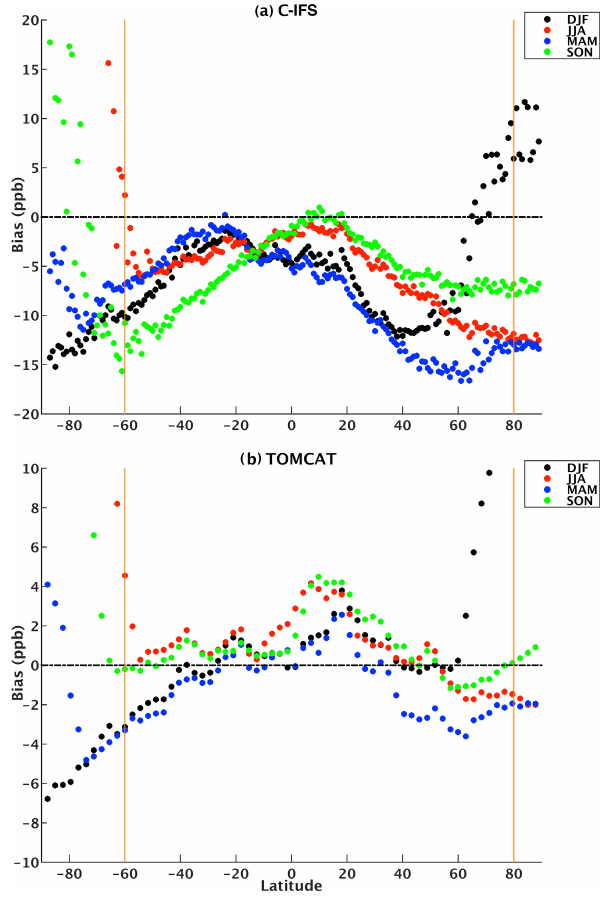
Figure 9. Zonal mean CH 4 stratospheric column bias for differ- ent seasons of the year 2010 plotted against latitude for the mod- els (a) C-IFS and (b) TOMCAT. MIPAS data are used as reference truth. Note the difference in the scaling of the y